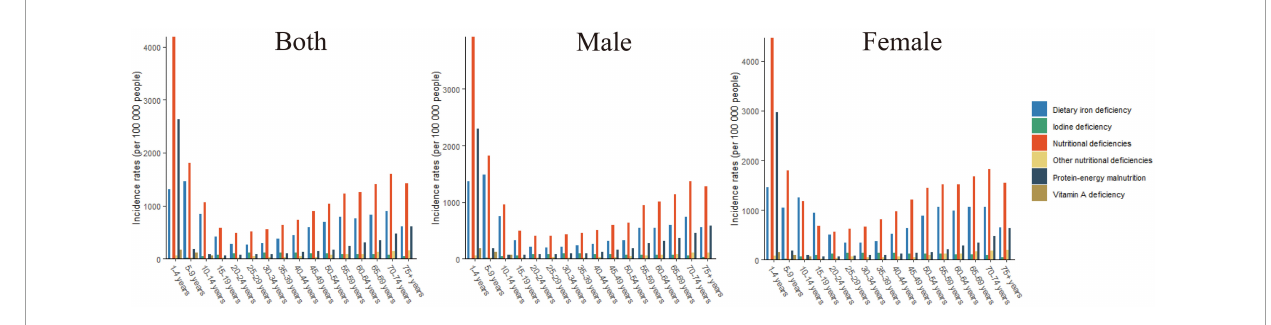
FIGURE4 The DALYs rates of overall nutritional deficiency and its main subcategories by age groups in 2019.